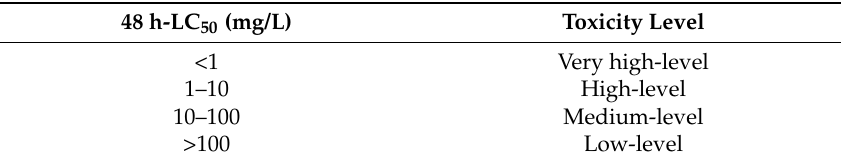
Table 2. Acute toxicity test classification criteria for Daphnia.